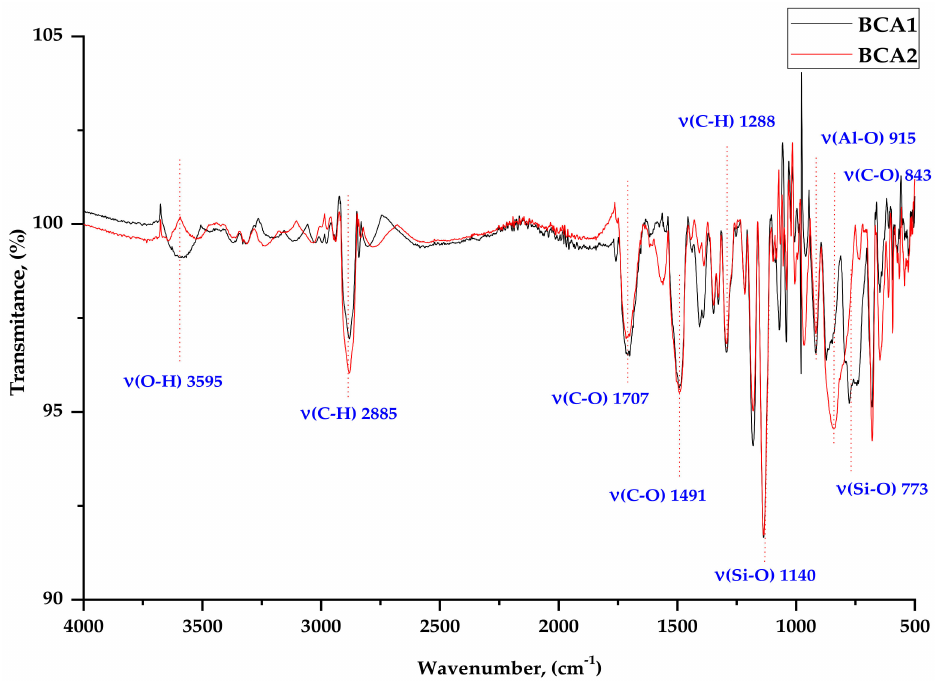
Figure 3. FTIR spectra for ashes BCA1 and